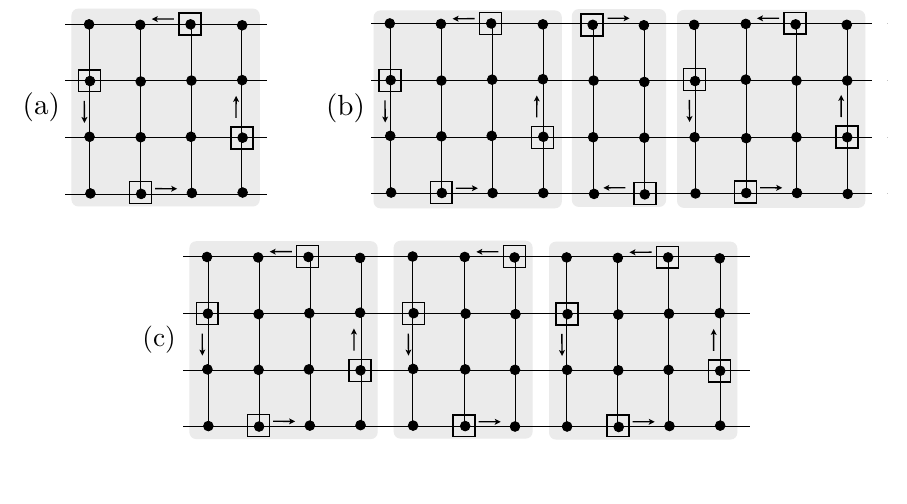
Figure 3: Guard configurations for n